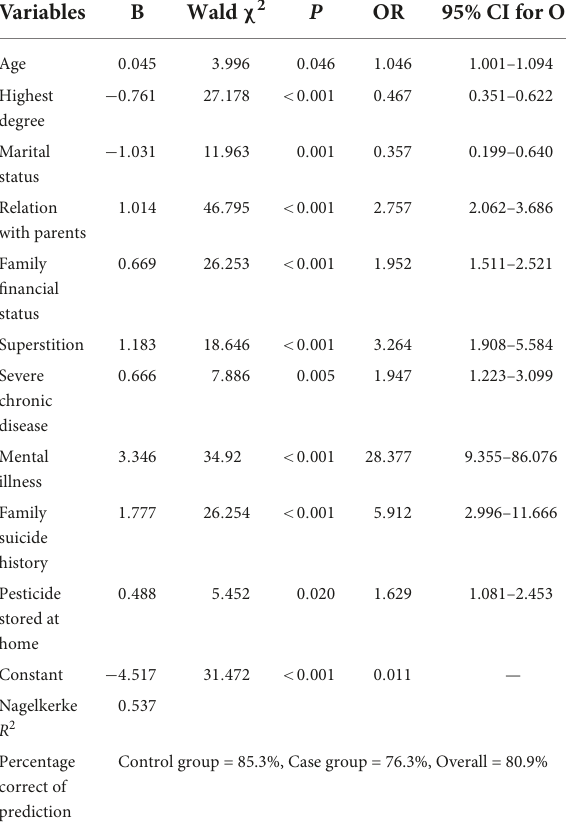
TABLE 4 The logistic regression prediction model of suicide. TABLE 5 Predicted evaluation indices of Back Propagation Neural Network (BPNN) with different hidden layers